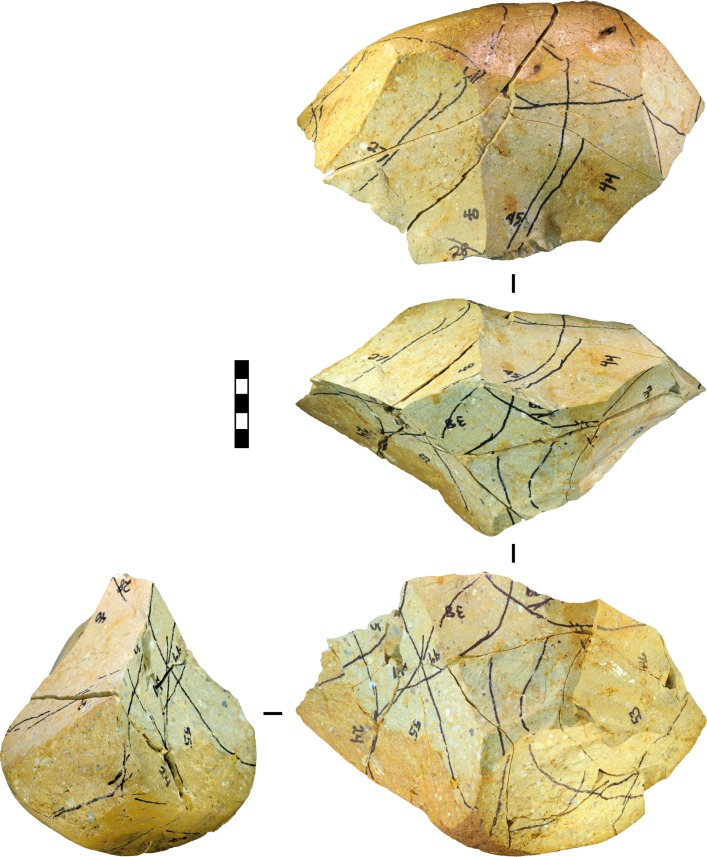
Experimental cobble core displaying a ‘chopper’ morphology.Silcrete, experiment 17, after 17 blows. The rounded morphology on the side of the cobble prevented the identification of potential platforms in that location, and reduction up to this point in the experiment progressed bifacially towards this rounded surface. Scale 50 mm.